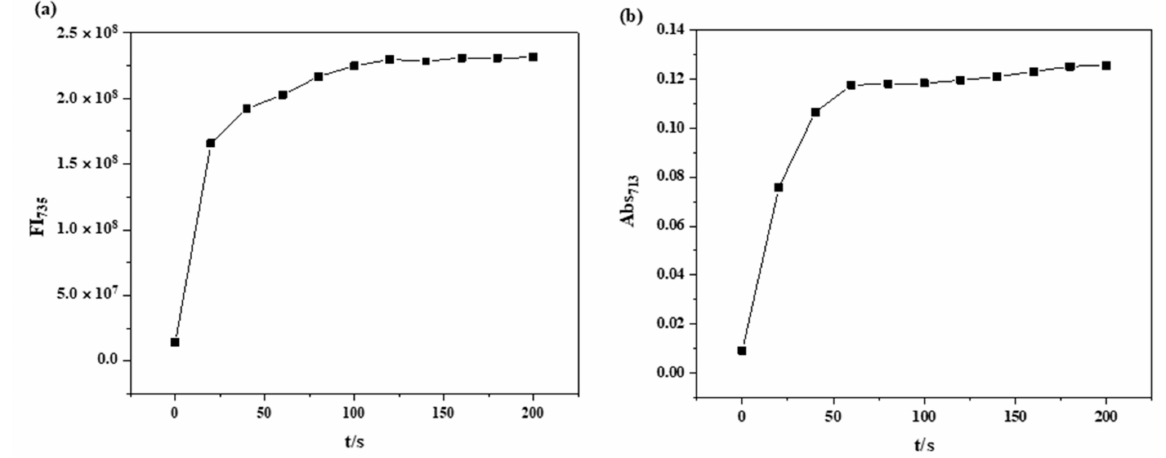
Figure 4. Time dependence of the RCya + Pd 2+ system at the excitation wavelength of 635 nm: ( a ) fluorescence intensity at 735 nm versus time, ( b ) UV-Vis absorbance at 713 nm versus time (RCya: 10 µ mol L − 1 , Pd 2+ : 40 µ mol L − 1